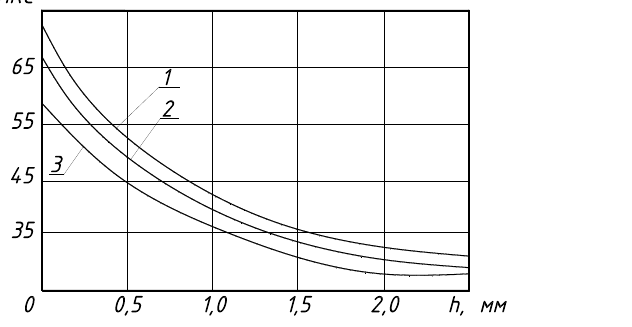
Fig. 3. Changes in the hardness of the depth of the plowshares